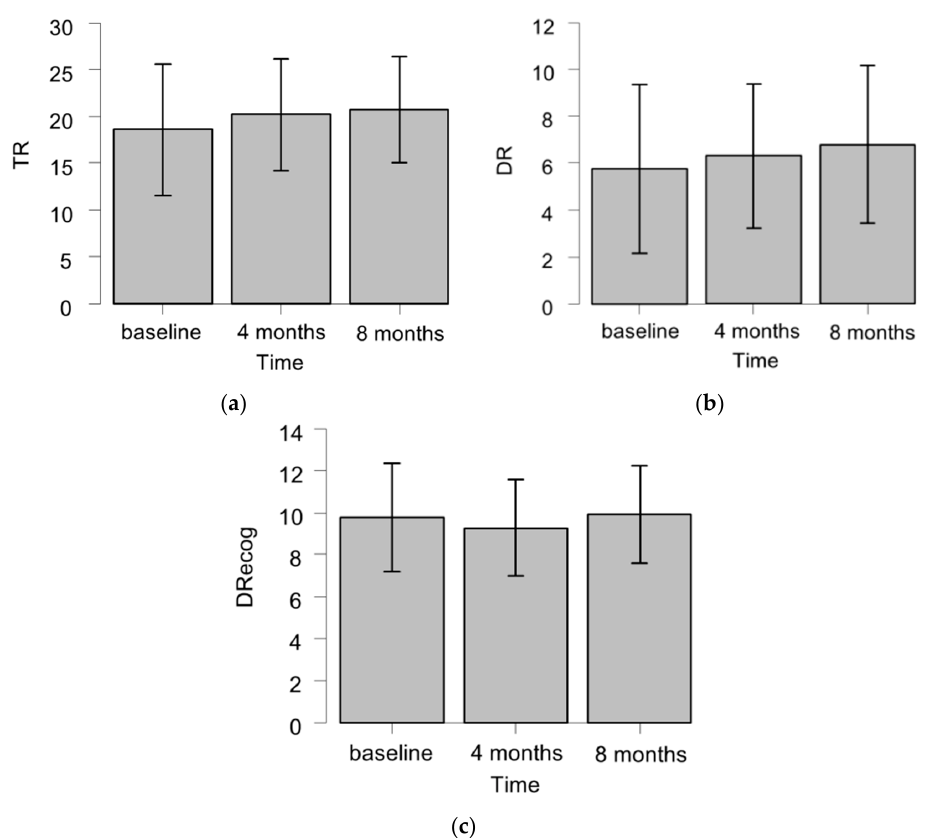
Figure 2. The HVLT-R TR ( a ); DR ( b ); and DRecog ( c ) scores of the patients who underwent the examination at the baseline, four months, and eight months after WBRT ( n = 29). The raw scores are indicated as mean ± SD.